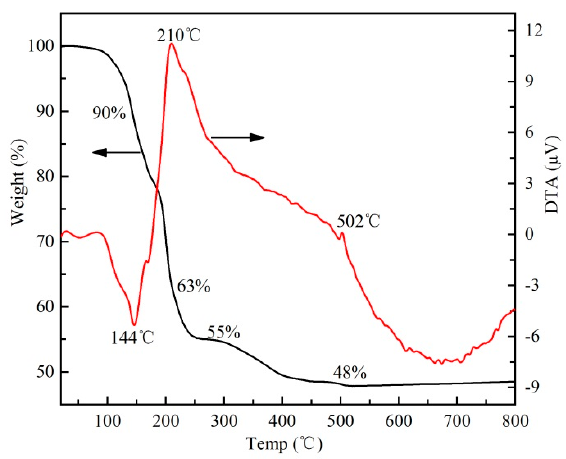
Figure 1. Thermogravimetric analysis and differential thermal analysis (TG/DTA) curve of BiFeO 3 dry